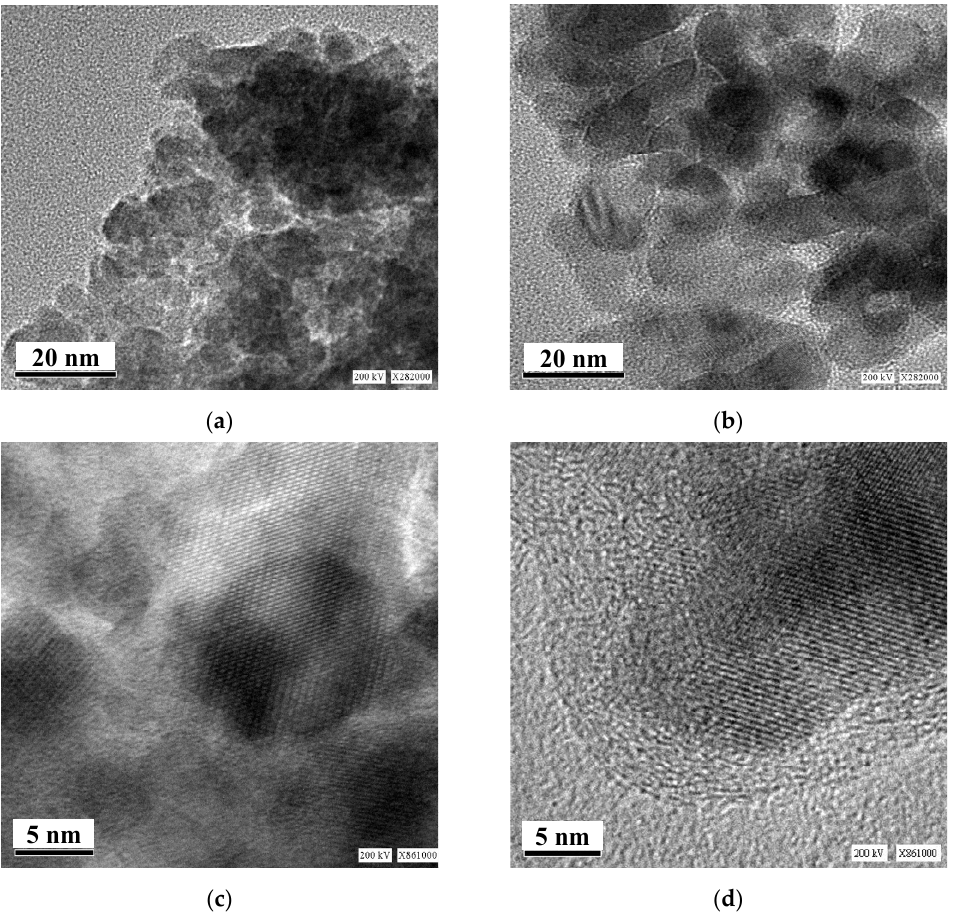
Figure 60. TEM ( a , b ) and HRTEM ( c , d ) images of CuFe 2 O 4 ( a , c ) and (CuFe 2 O 4 ) 0.95 (SnO 2 ) 0.05 ( b , d ). Adapted from Ref. [91] with permission from Springer Nature: Hyperfine Interactions, “Study of CuFe 2 O 4 –SnO 2 nanocomposites by Mössbauer spectroscopy with high velocity resolution”, Osh ‐